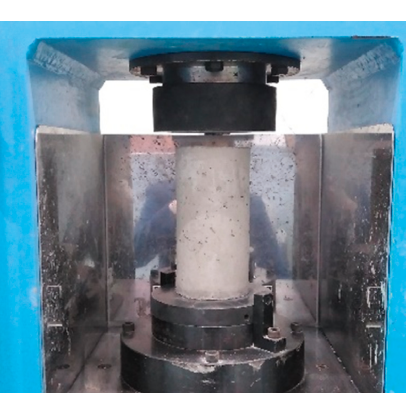
Figure 1: Compression test setup.